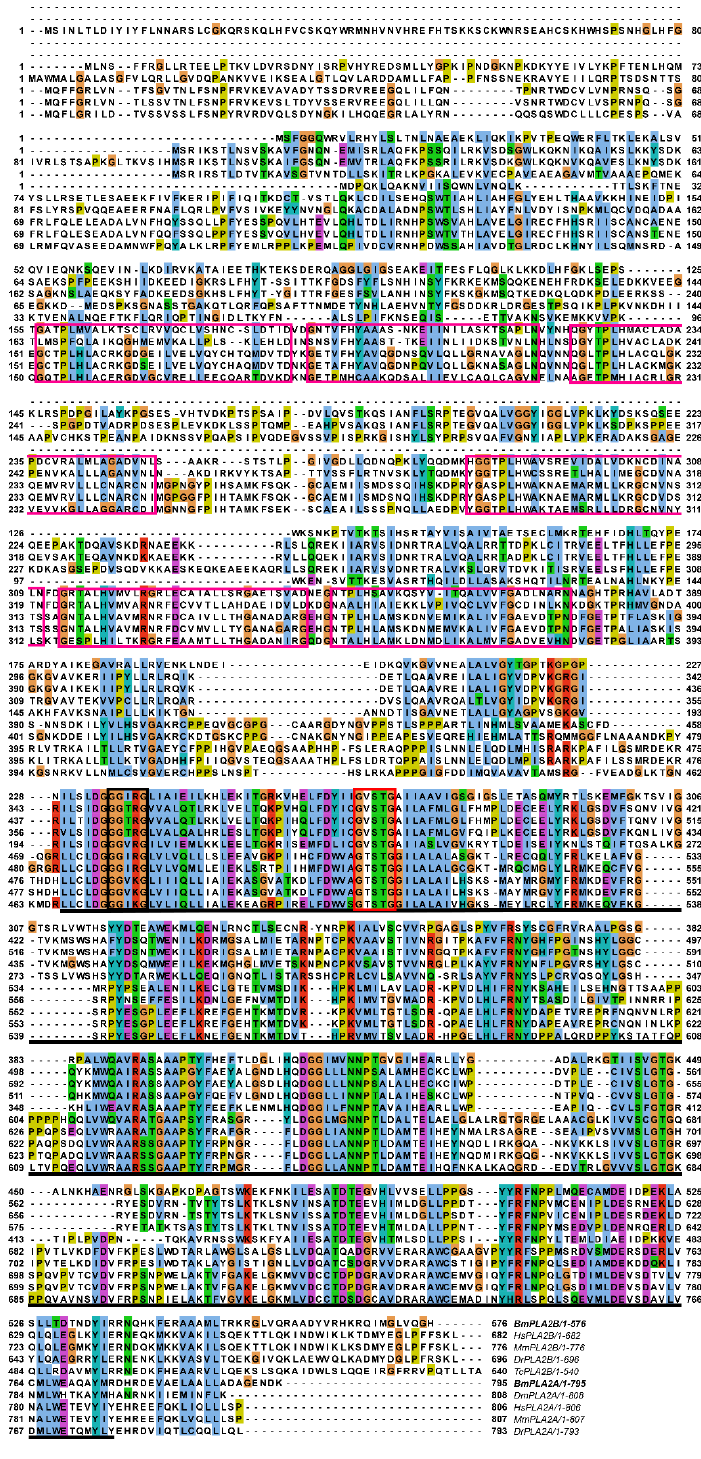
Figure 2. Alignment of BmiPLA2A and BmiPLA2B protein with other homologous proteins.